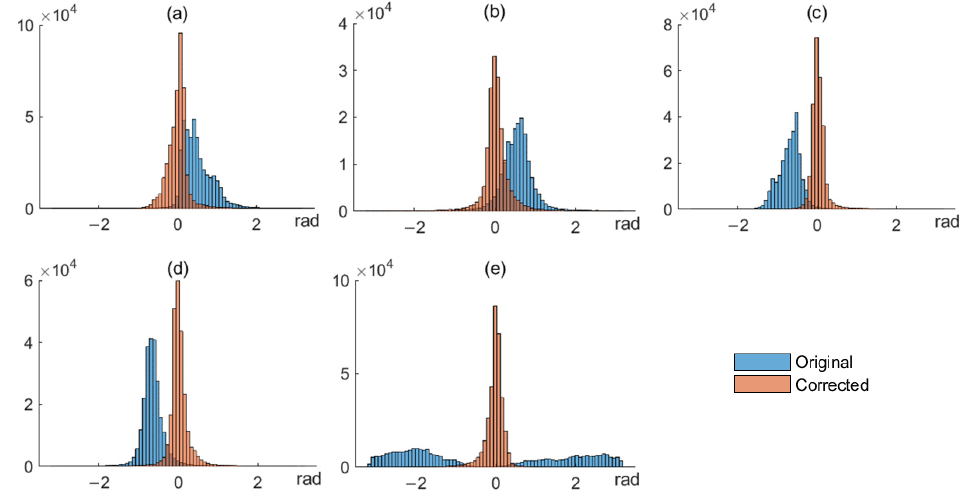
Figure 4. Original phase, systematic error phase, and corrected phase of five typical interference pairs in the experimental area. ( a , b ) Error related to elevation; ( c , d ) overall phase offset; ( e ) radar center deviation caused by blasting construction.